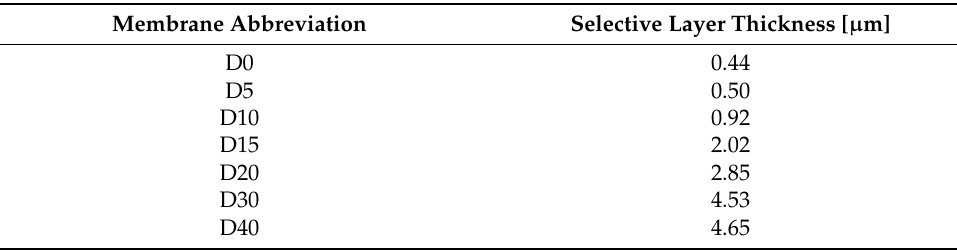
Table 2. Thickness of the selective layer of dynamic composite membranes according to SEM